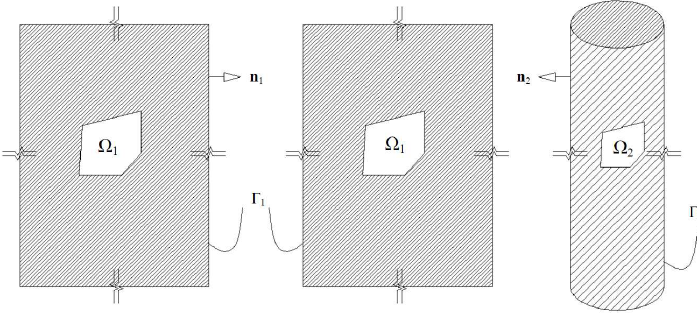
Figure 3. Geometry of the viscoelastic media, domains Ω 1 and Ω 2 , boundaries Γ 1 and Γ 2